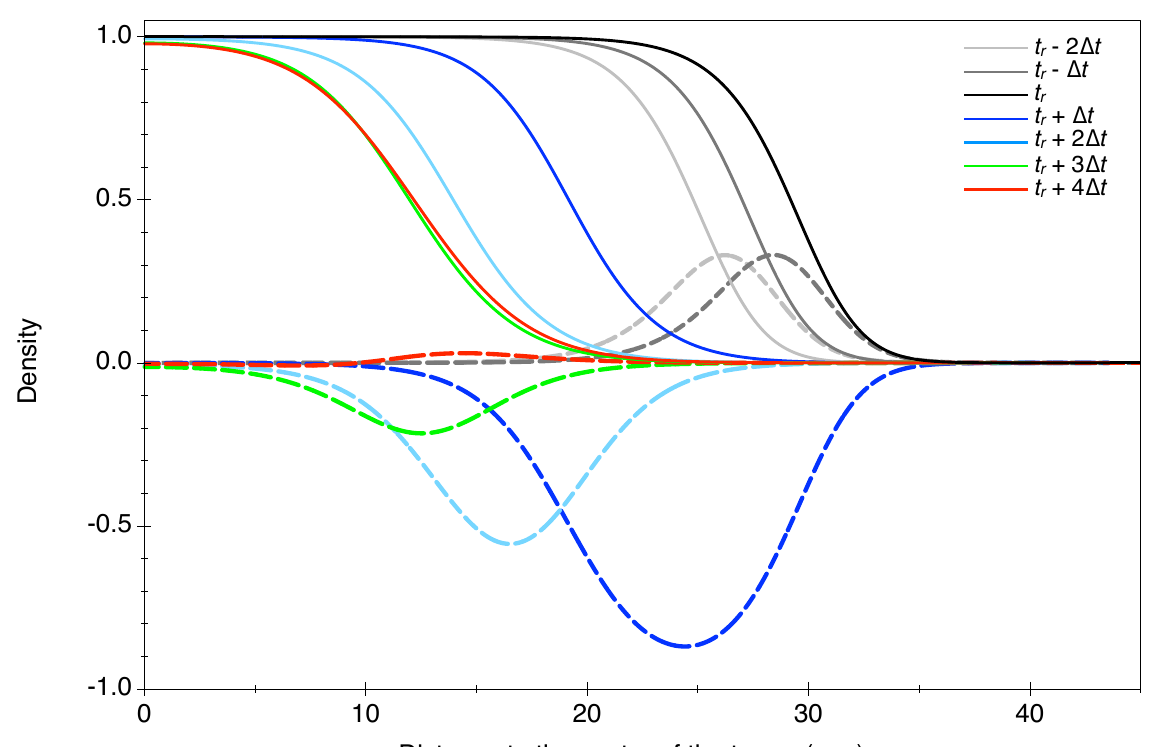
Figure 1. Cell density (full lines) and proliferating/killed cell density (dashed lines) profiles for different times: before (light and dark gray lines), at the time of RT (black lines), and after RT (colored lines). The time interval between two profiles is ∆ t = 1.1 yr. The profile of proliferating/killed cells is obtained by subtracting two successive profiles.